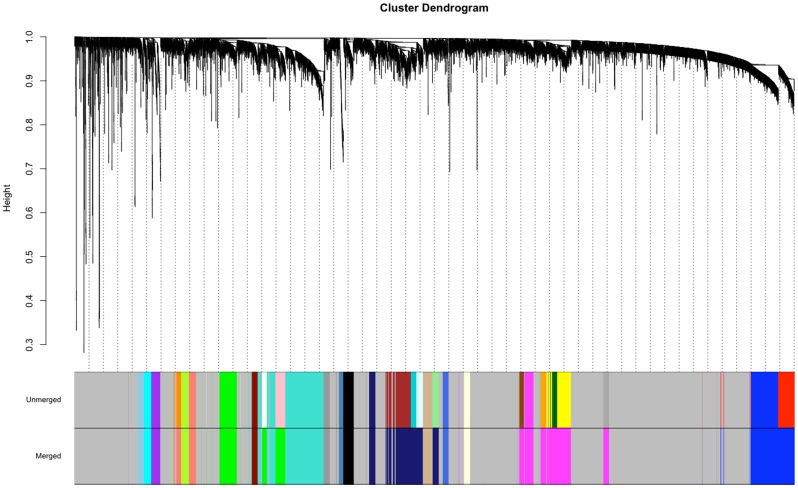
Hierarchical clustering of gene modules and module color assignments.Top: clustering tree. Bottom: initial unmerged colors and subsequent merged (final) module color assignments.